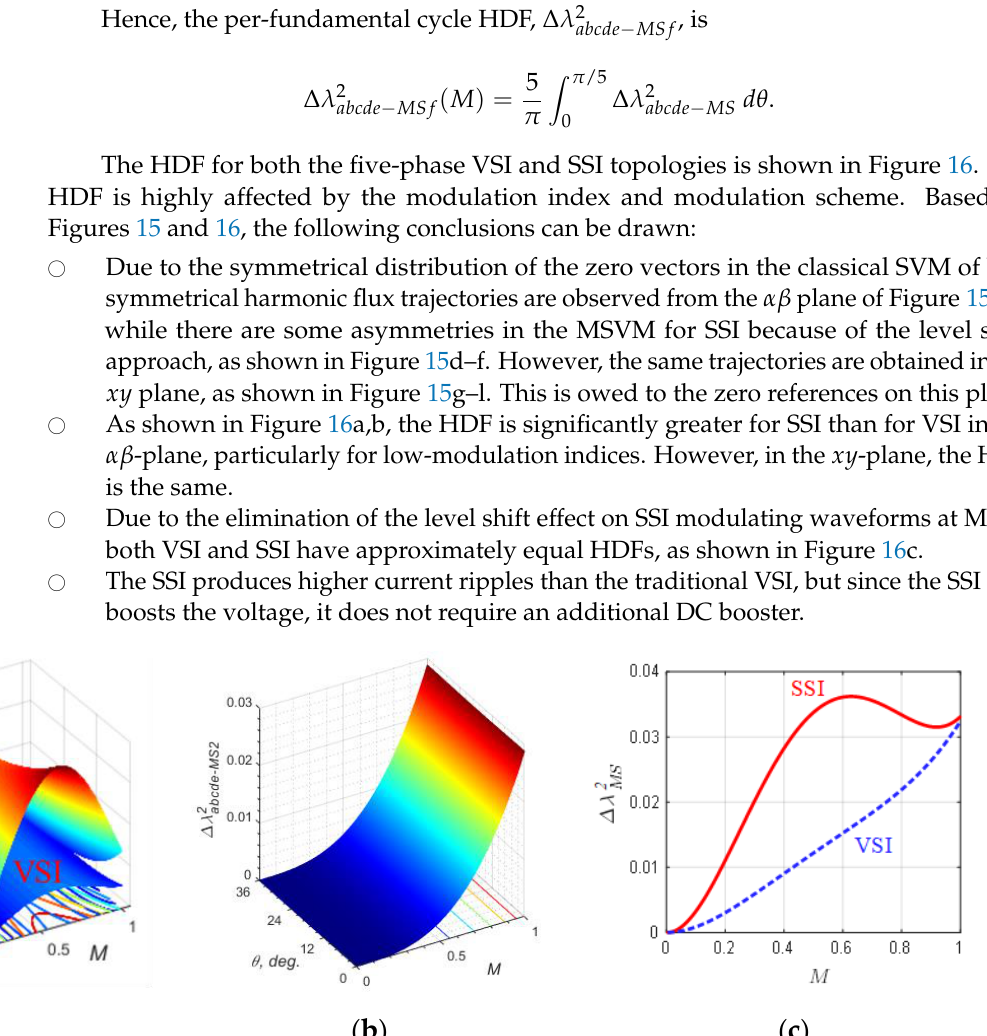
Figure 16. Harmonic distortion flux for both five-phase VSI and SSI [26]. ( a ) HDF in 𝛼𝛽 plane for both VSI and SSI. ( b ) HDF in 𝑥𝑦 plane for both VSI and SSI. ( c ) Total HDF for both VSI and SSI.